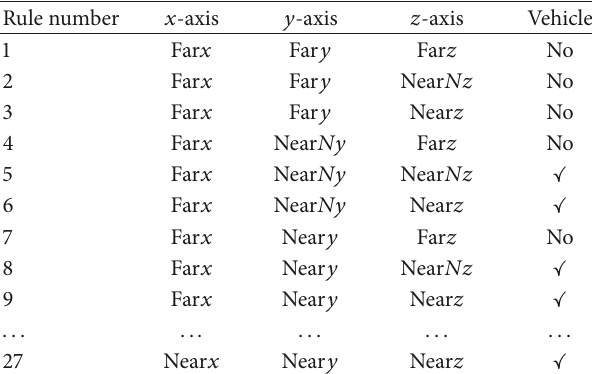
Table 4: Rule base for the magnetic fuzzy